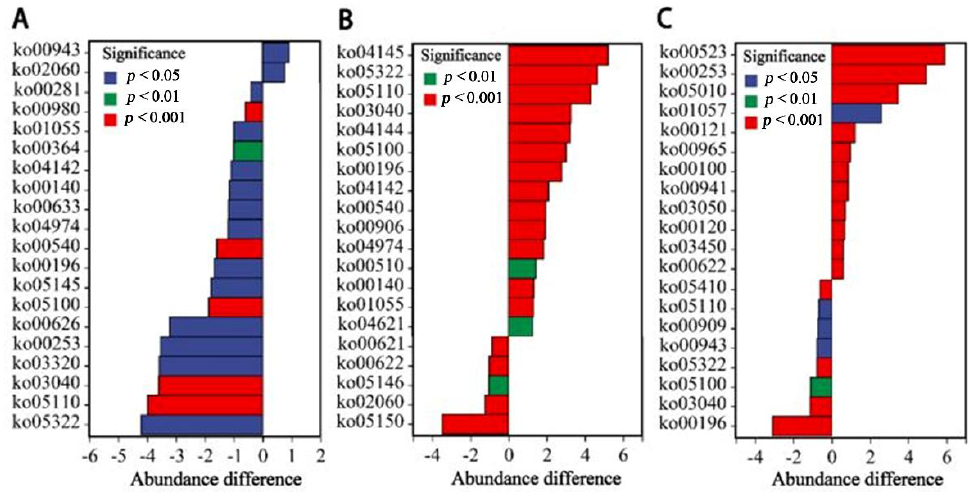
Figure 7. Metabolic pathway differential analysis. Comparison between June and April ( A ). Comparison between August and June ( B ). Comparison between October and August ( C ). Positive values represent that the abundance of pathways this month is higher than that of the previous month; negative values represent that the abundance of pathways in the previous month is higher than that of this month. The pathway descriptions are shown in Table 4. Table 4. Metabolic pathway description (KEGG).